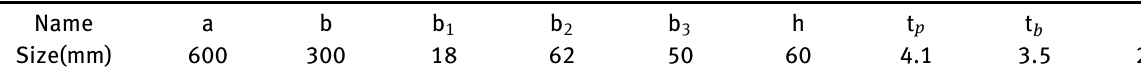
Table 1: Dimensions of stiffened composite panels at deck and side